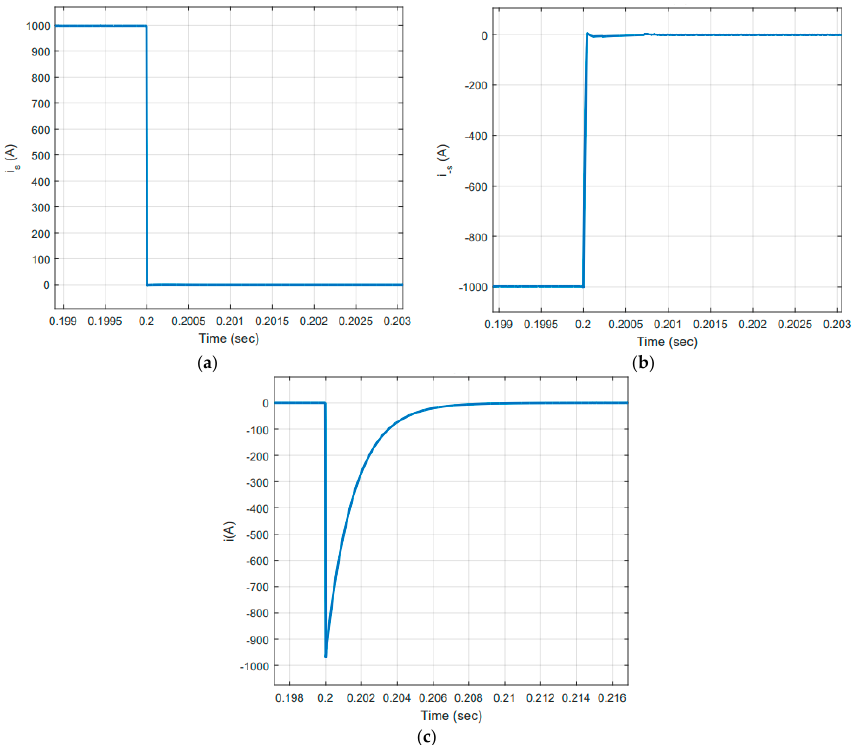
Figure 10. Negative pole-to-ground fault, ( a ) positive pole current, ( b ) negative pole current, and ( c ) terminal capacitor current.